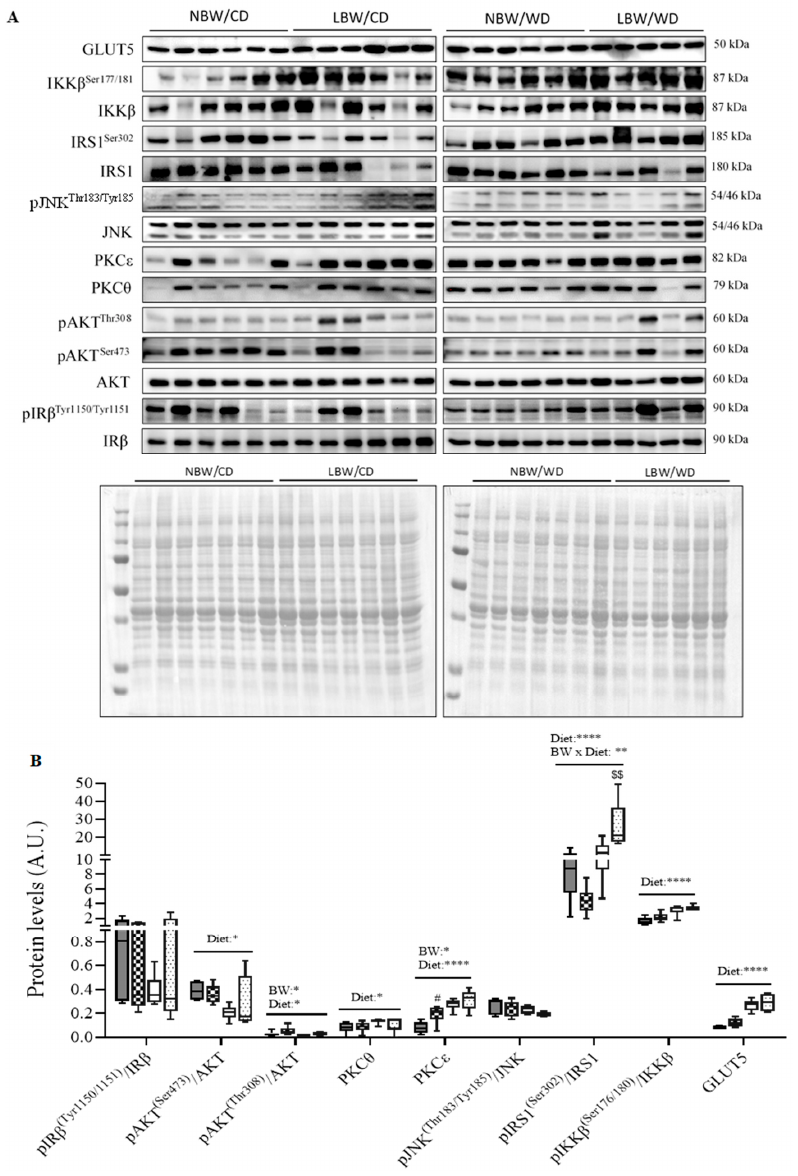
Figure 10. Levels of proteins involved in insulin signaling and glucose transport at postnatal day 145. Panel ( A ) shows representative cropped blots; panel ( B ) indicates normalized densitometry values of proteins. Data are min. to max. box and whisker plots for 5 to 6 animals per group. *, **, and **** for p < 0.05, p < 0.01, and p < 0.0001, respectively, represent the main effect of birth weight (BW) or diet (Diet) using a regular two-way ANOVA. # denotes significant difference ( p < 0.05) between NBW/CD versus LBW/CD; $$ indicates p < 0.01 when comparing NBW/WD versus LBW/WD by Bonferroni post hoc